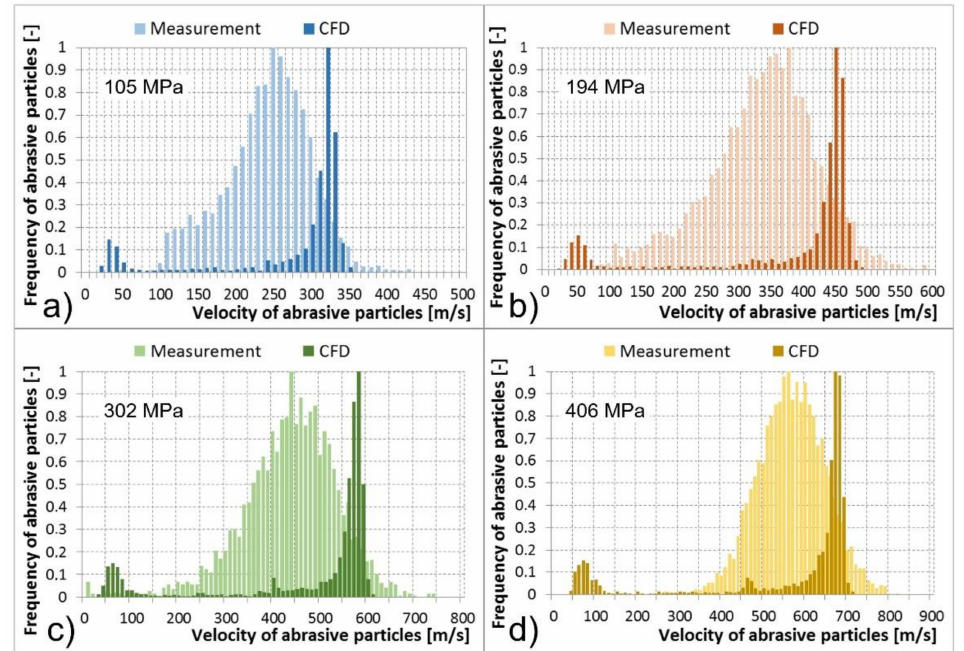
Figure 16. Abrasive particle velocities at the abrasive nozzle outlet, measurement vs. computational models for determined water pressure levels, and an abrasive particle mass flow rate of 400 g/min: ( a ) 105 MPa; ( b ) 194 MPa; ( c ) 302 MPa; ( d ) 406